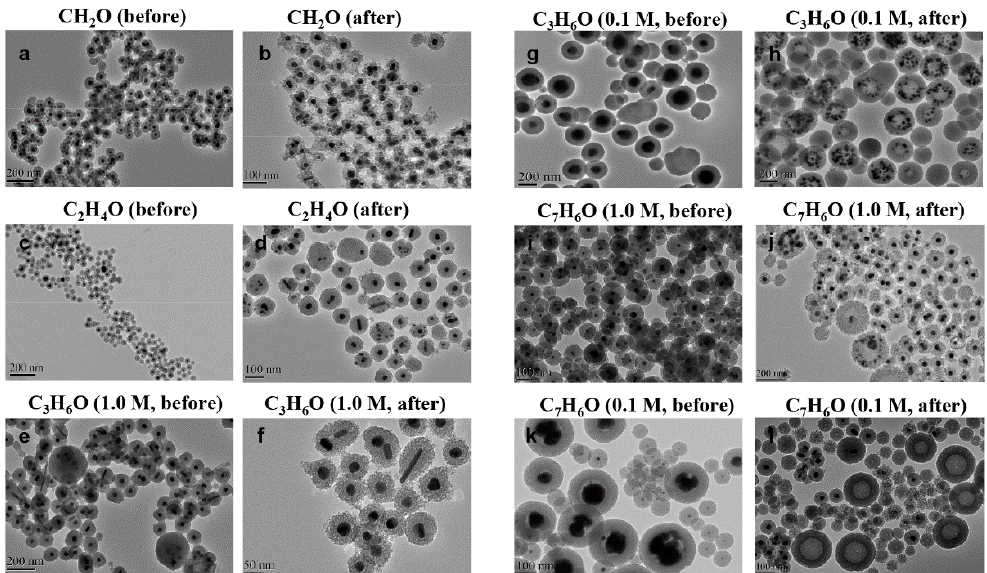
Figure 2. TEM images of Ag@SiO 2 nanoparticles prepared by CH 2 O before ( a ) and after ( b ), C 2 H 4 O before ( c ) and after ( d ), C 3 H 6 O (1.0 M) before ( e ) and after ( f ), C 3 H 6 O (0.1 M) before ( g ) and after ( h ), C 7 H 6 O (1.0 M) before ( i ) and after ( j ), and C 7 H 6 O (0.1 M) before ( k ) and after ( l ) nitrobenzene hydrogenation.